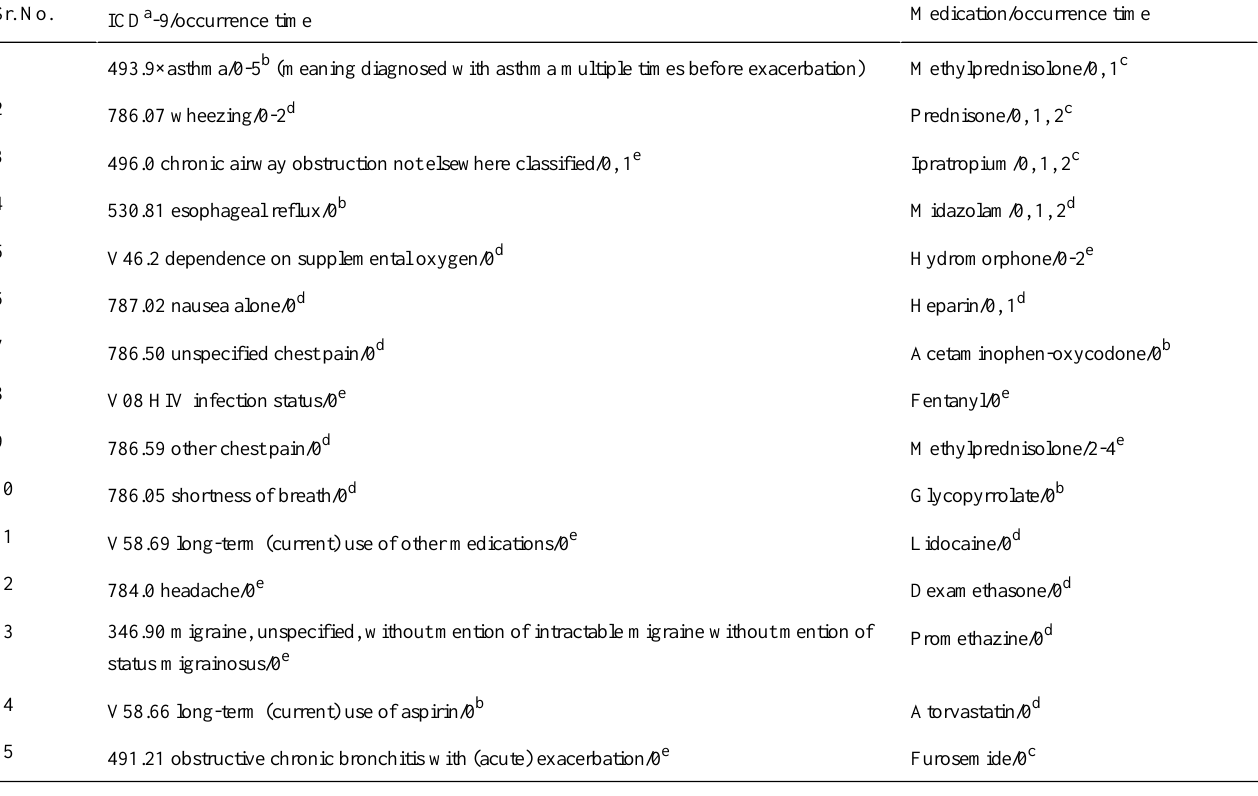
Table 4. Clinical variables with the top-ranked weights (/N stands for the clinical variable presented in N months before the prediction date).